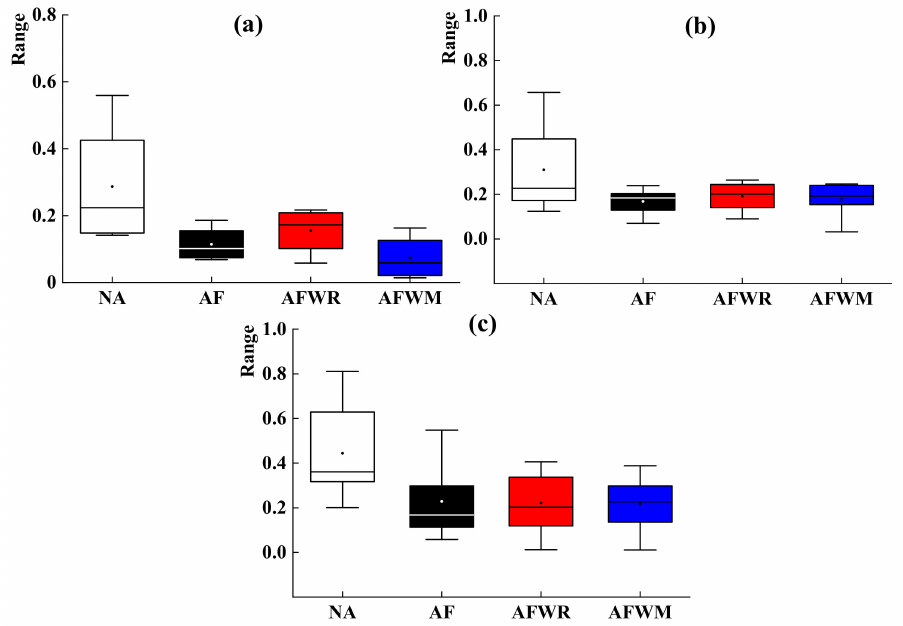
Figure 11. RE of four assimilation settings at different hydrological stations: ( a ) Dage; ( b ) Gubeikou; and ( c )